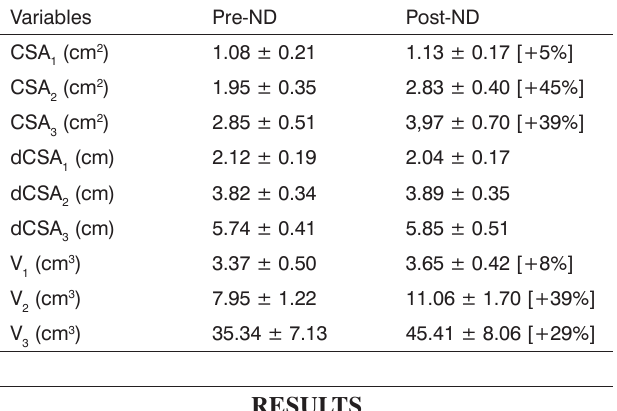
Table 1. Reference values for cross-sectional areas (CSA CSA , CSA ), distances from nostrils (dCSA 2 3 and volumes in adults without signs of nasal obstruction, before (Pre-ND) and after (Post-ND) the administration of nasal decongestants as reported by Gomes 7 and Camargo 12 .